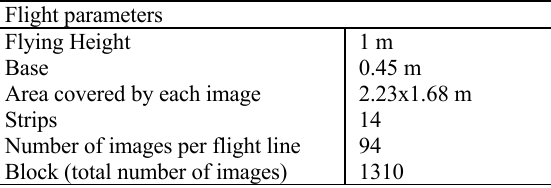
Table 1. Data quality and LOD introduced by GSA